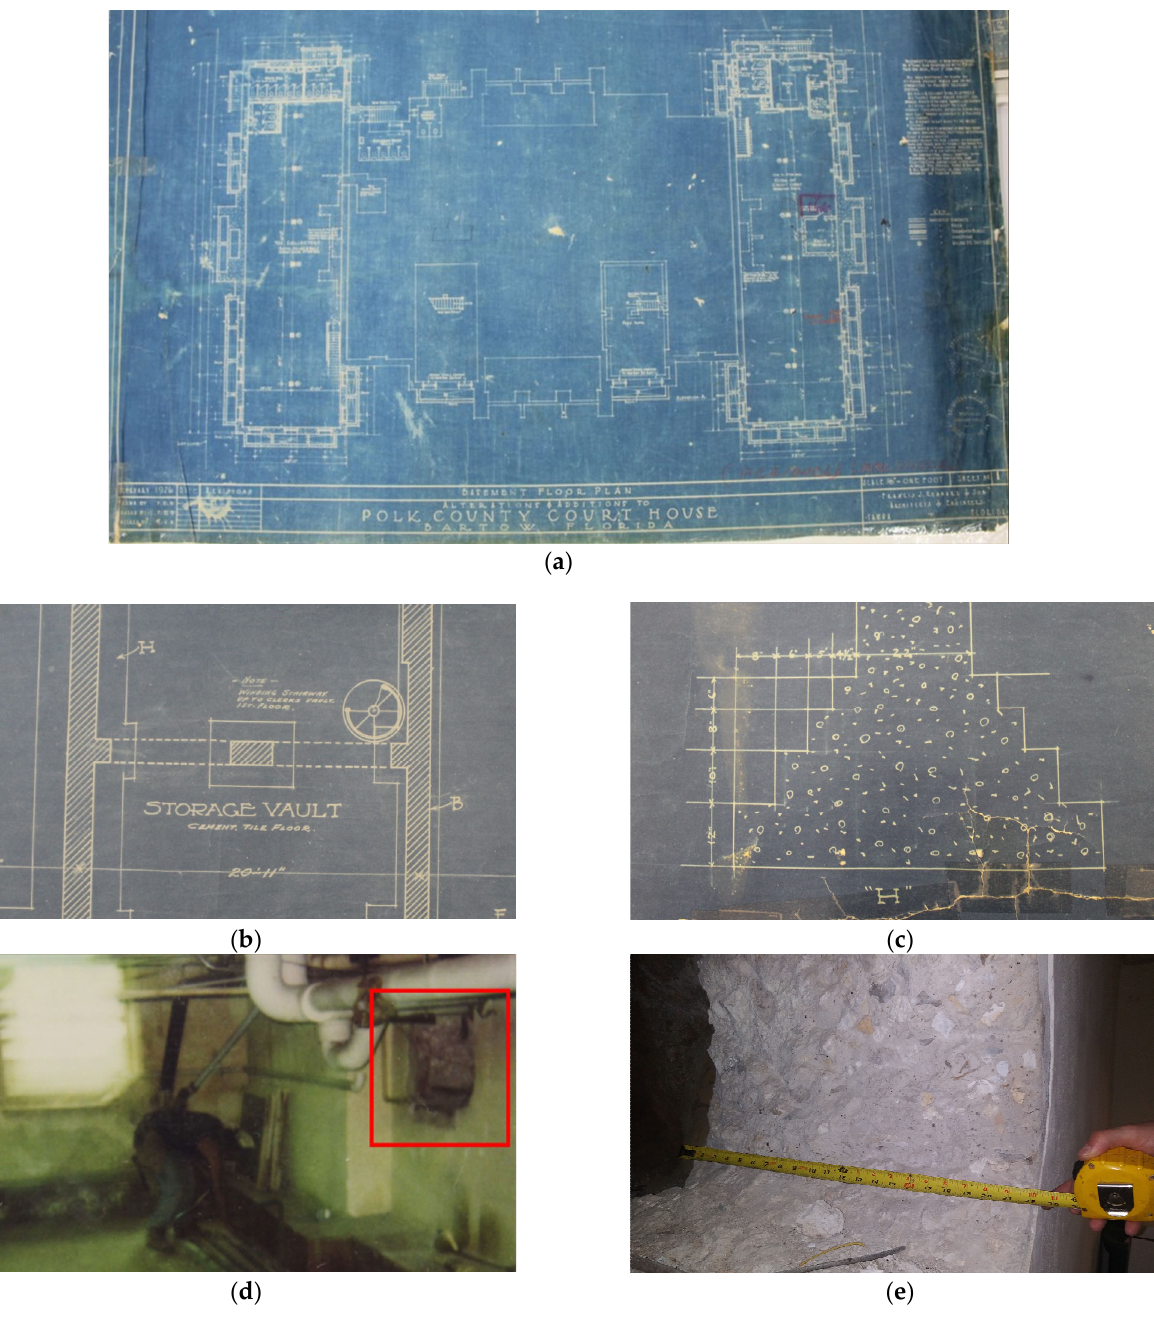
Figure 24. Semantic data capture of the OPCC: ( a ) basement floor plan of the original 1908 blueprints; ( b ) 1908 blueprint of southeast basement wall; ( c ) 1908 blueprint of Type-H foundation with 22 in (0.56 m) wall; ( d ) 1995 renovation showing exposed wall section; ( e ) measurement of the constructed wall section.